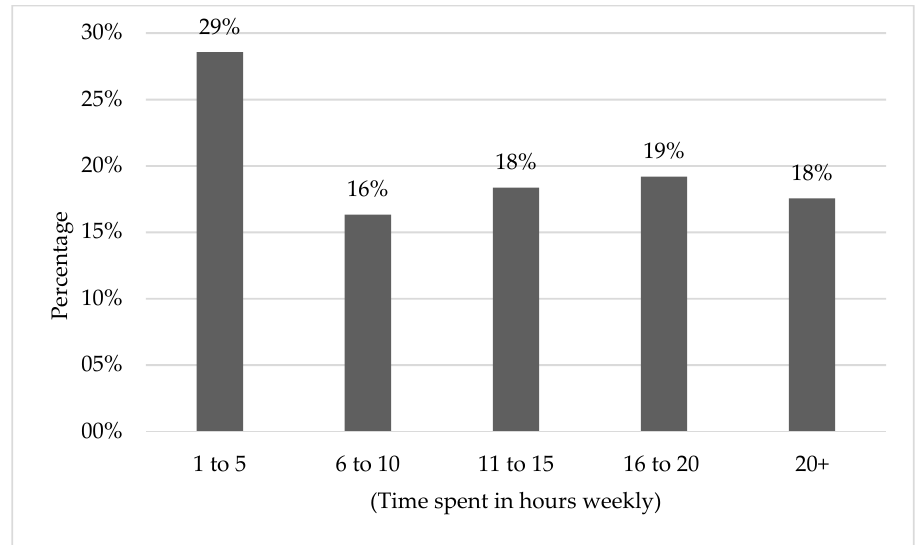
Figure 3. Likelihood of using earplugs and ear protection in the future.